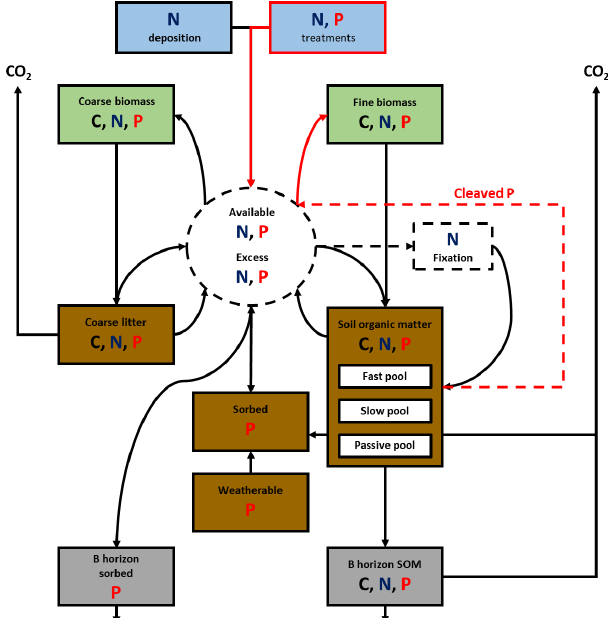
Figure 1. A simplified schematic of the key flows and pools of C, N, and P within N 14 CP, adapted from the full schematic available in Davies et al. (2016b). Red lines highlight modifications to N 14 CP for the purpose of this work, including adding experimental nutri- ents and allowing uptake of cleaved P to be more flexible. Solid lines indicate input to another pool, and a dashed line indicates ei- ther a feedback or interaction with another pool. In the model, N can enter the available pool via atmospheric deposition, nutrient treat- ments, biological fixation, and decomposition of coarse litter and SOM. For P, the two main sources are the inorganic sorbed pool and the turnover of SOM. The former is derived initially from the weatherable supply of P, defined by its initial condition (P Weath0 ). P can also be added to this pool experimentally as with N. The dashed line going from available N and P to N fixation represents the down- regulation of N fixation by N deposition and the dependency of N fixation on P availability. The cleaving of organic P from SOM and its incorporation into the plant-available nutrient pool are rep- resented by the dashed red line and its uptake by plants, determined by P CleaveMax , shown with a solid red